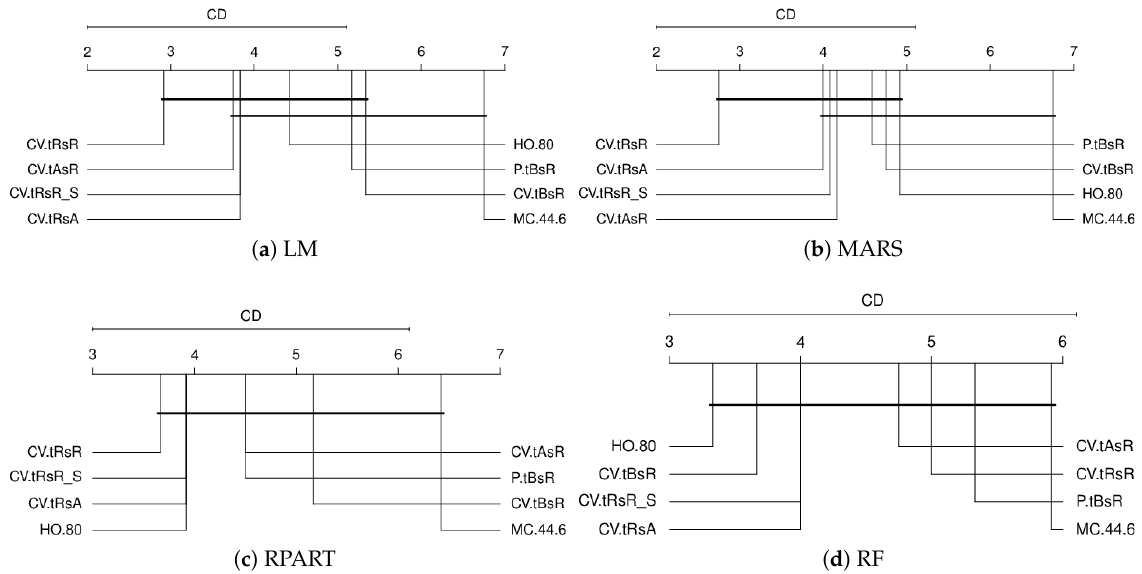
Figure 15. Critical difference diagram according to Friedman–Nemenyi test (at 5% confidence level) for a subset of estimation procedures using real